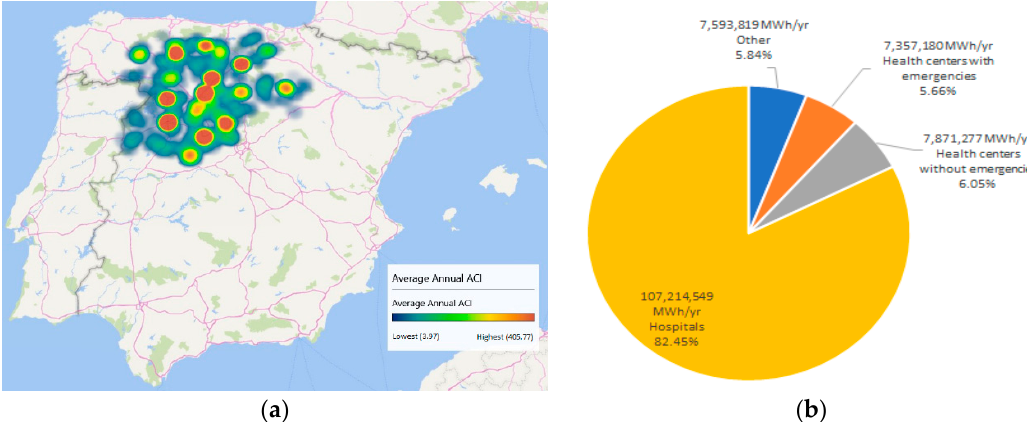
Figure 1. ( a ) Geographical distribution of the average annual Area Consumption Index (ACI) in the 2015–2018 period for the building stock of the health system of the Castilla y León region. ( b ) Electric energy consumption share of the evaluated building stock. Values show the average total annual electric energy consumption for each administrative group (Wh·year − 1 ).